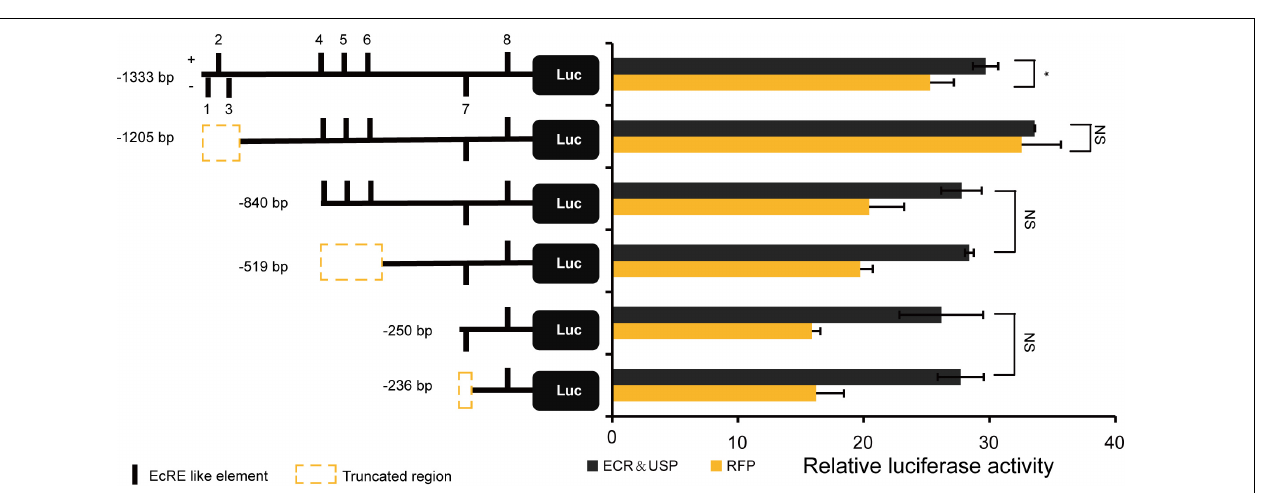
FIGURE 3 | Regulation of EcRE on the Bombyx mori ERR ( BmERR ) promoter. Comparison of the activity of different truncated forms of BmERR promoter with the overexpression of BmEcR and BmUSP and RFP through the dual luciferase reporter system. 1–8, EcRE like 1–8, respectively. EcR and USP, the overexpression of BmEcR and BmUSP protein. RFP , the overexpression of red fluorescent protein (RFP). * P < 0.05. NS, not significant; t